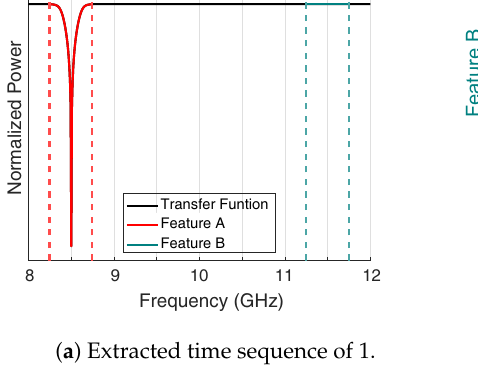
( d ) Feature space of 1.